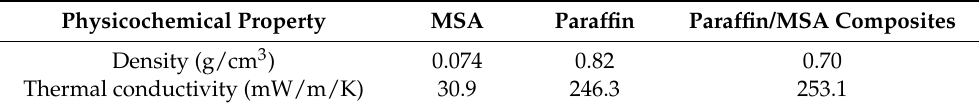
Table 1. Physical properties of the MSA, paraffin and paraffin/MSA